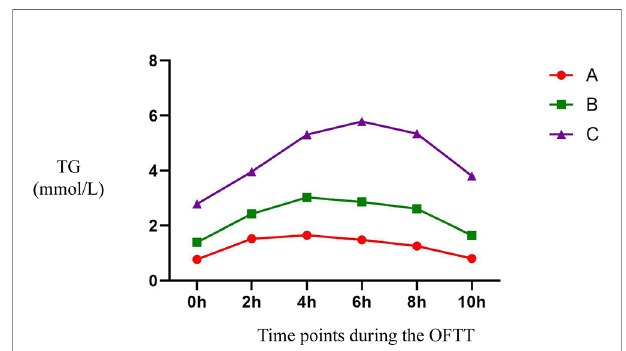
FIGURE 1 | Trend of TG at different time points during the OFTT. Blood was taken at baseline and every 2 hours after the OFTT. The changing trend of triglycerides concentrations were analyzed to determine differences of lipids metabolism among groups with different fasting triglycerides concentrations. All data are expressed